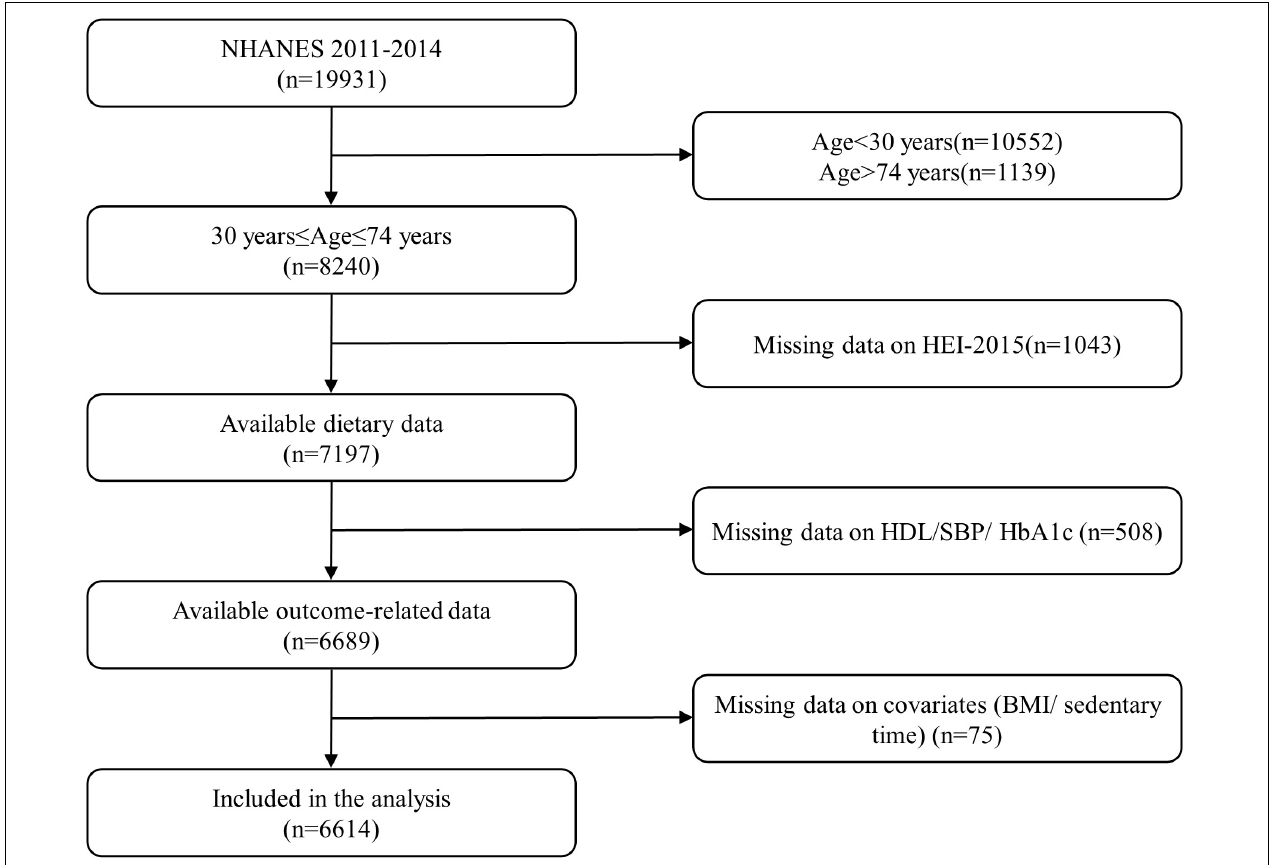
FIGURE 1 | Flow diagram of the study participant selection. NHANES, National Health and Nutrition Examination Survey; HEI-2015, Healthy Eating Index-2015; HDL, high-density lipoprotein; SBP, systolic blood pressure; HbA1c, glycated hemoglobin A1c; BMI, body mass